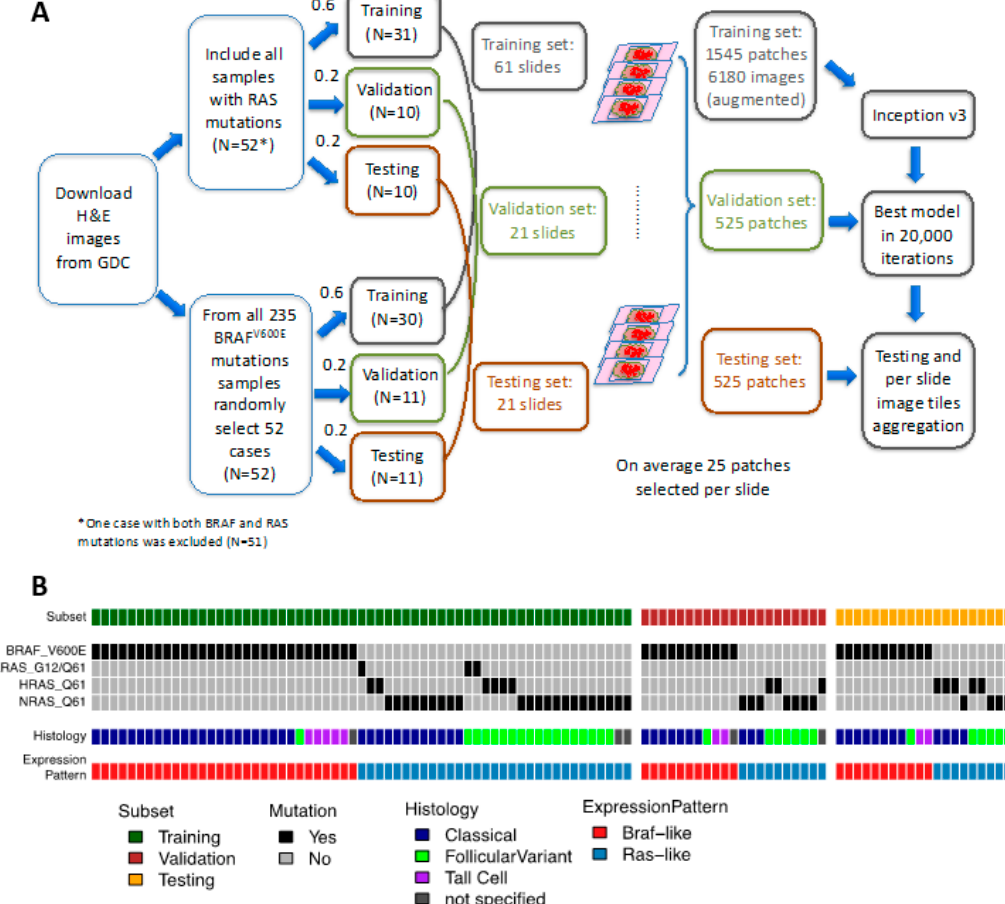
Figure 1. Study cohort. ( A ) Sample selection, allocation, and analysis strategy. Formalin-fixed, para ffi n-embedded (FFPE) slides Hematoxylin and eosin (H&E) stained images were downloaded from GDC repository. Samples with RAS or BRAF V600E mutations were allocated into training, validation, and testing sets with ratios of 0.6, 0.2, and 0.2, respectively. On average there were 25 patches selected per slide. The Inception V3 framework was applied on the training set for 20,000 iterations. The model with the highest accuracy in validation set was chosen as the final model. Classifications were run on an independent testing set and the results were aggregated per slide. ( B ) The oncoprint depicting the molecular characteristics and histological subtypes of samples used in this